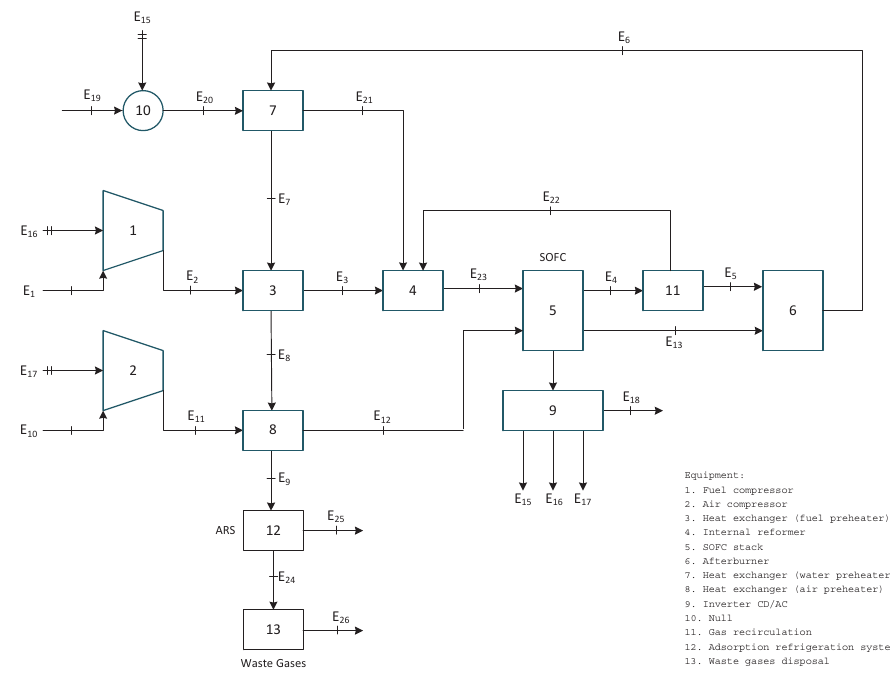
Figure 1. Schematic diagram of the solid oxide fuel cell-vapor absorption refrigeration hybrid